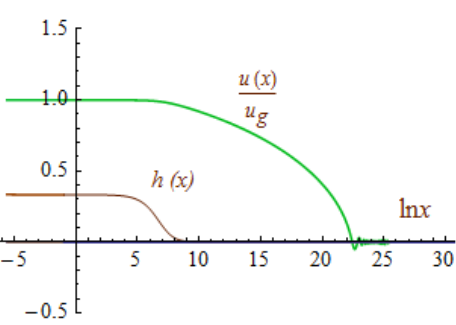
Figure 6. Solution to Equations (21)–(24) corresponding to the superheavy black hole located in the center of the Milky Way Galaxy. u 2 g = 22, and x 2 g = 2.99985 u − 2 g . The green line is u ( x ) / u g , and the brown line is h ( x ) . The horizon x h ( ln x h = 63.96 ) is far outside this